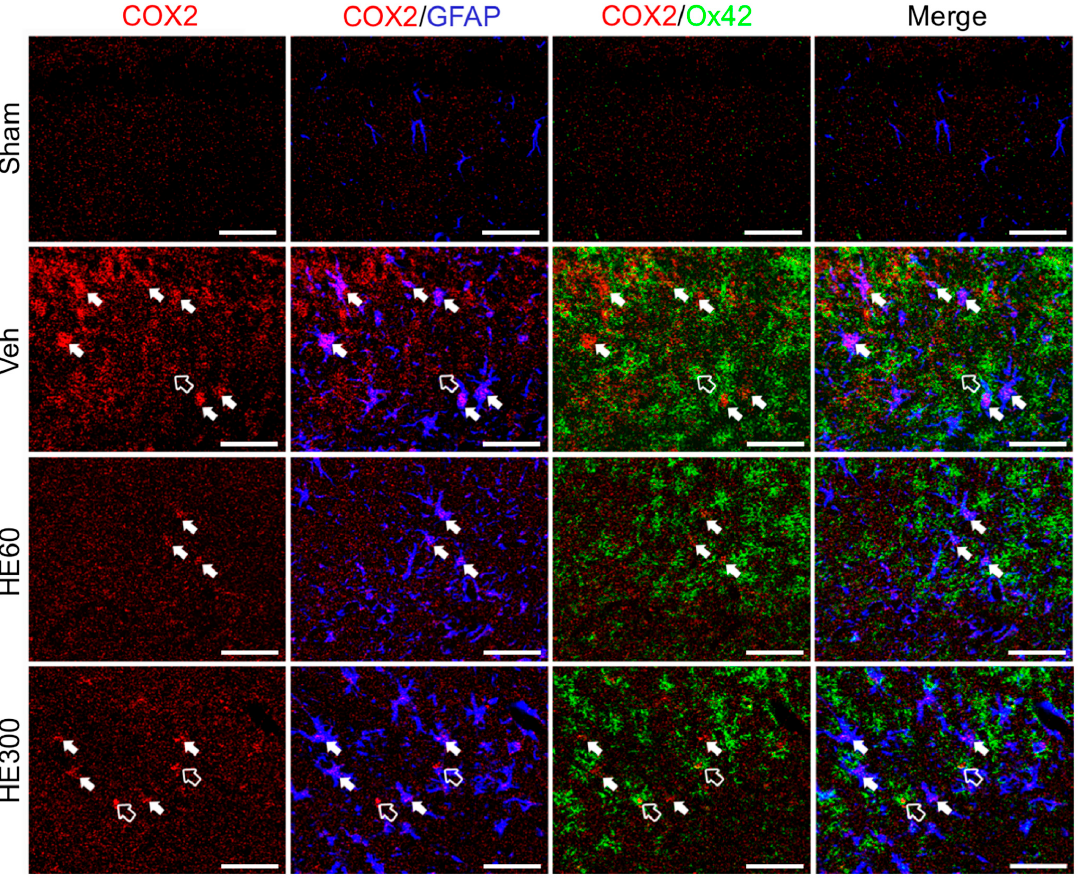
Figure 5. HE treatment at 60 mg/kg suppressed hippocampal COX2-expressing glial cells after pilocarpine-induced SE. Triple immunohistochemistry for COX2 (red), GFAP (blue), and Ox42 (green) demonstrated that COX2-expressing cells in the Veh-treated group turned out to be GFAP-positive astrocytes (filled arrows) and Ox42-positive microglia (hollow arrow). In the group treated with 60 mg/kg HE, COX2/Ox42-coexpressing cells were not observed, and COX2/GFAP immunoreactivity was reduced. However, in the group treated with 300 mg/kg HE, COX2-expressing astrocytes and microglia were comparable with those in the Veh-treated group. Scale bar: 50 μ m.